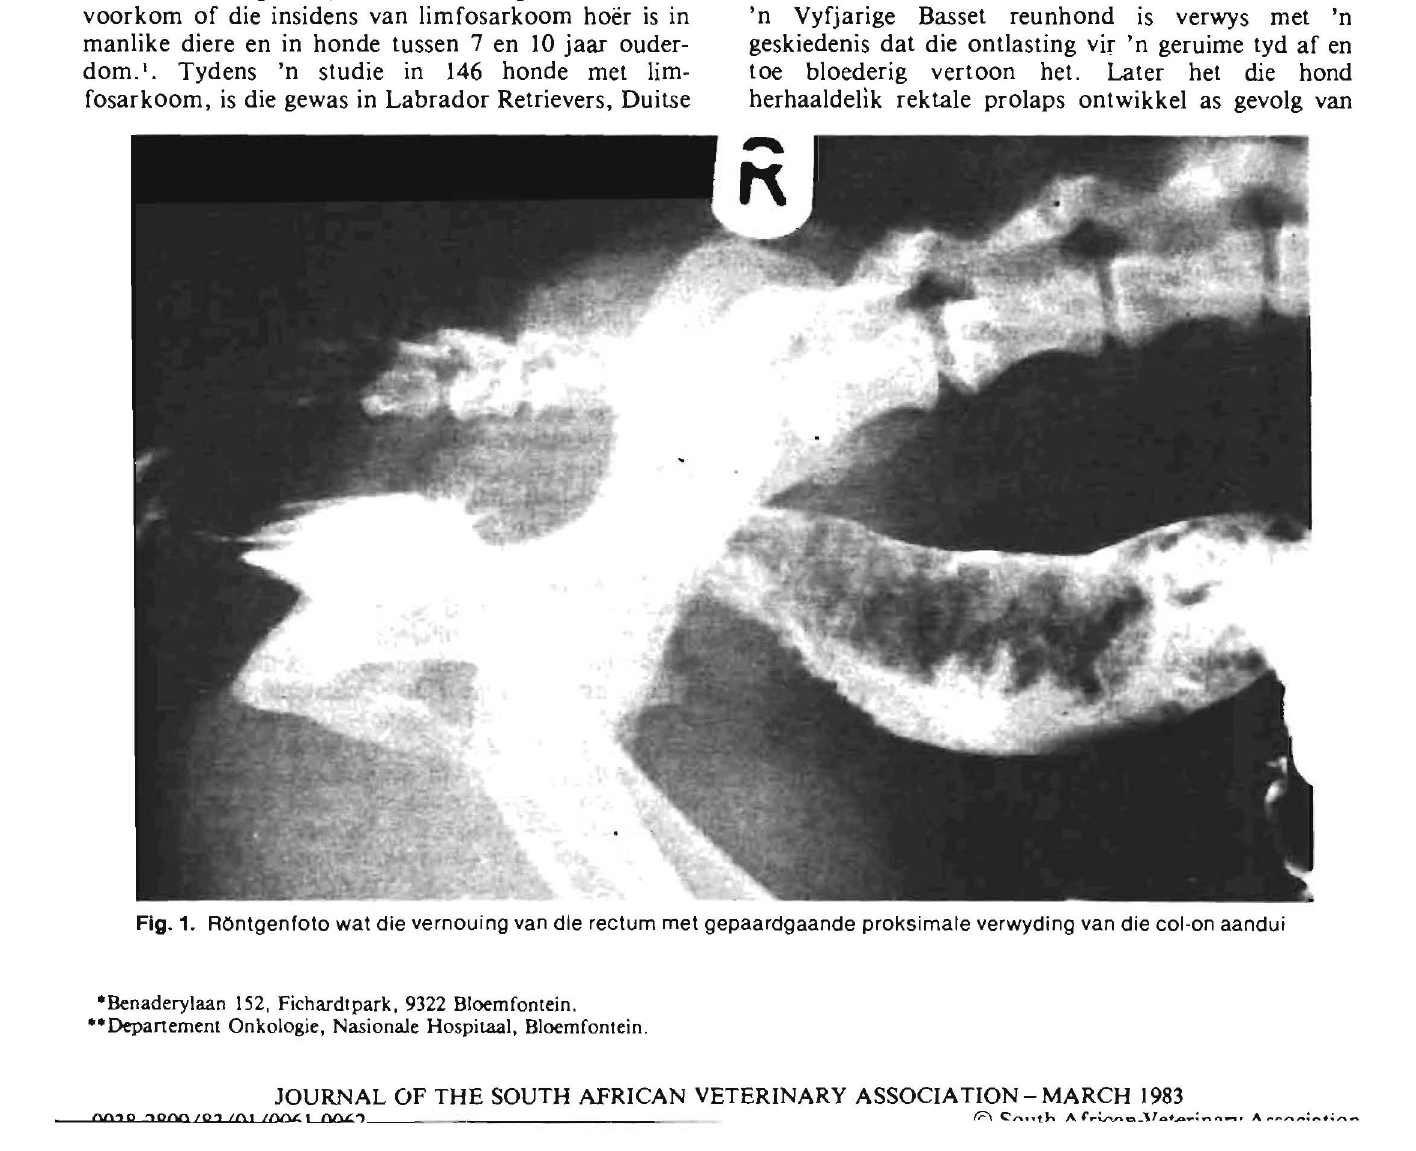
Fig. 1. ROntgenfoto wat die vernouing van die rectum met gepaardgaande proksimale verwyding van die col·on aandui